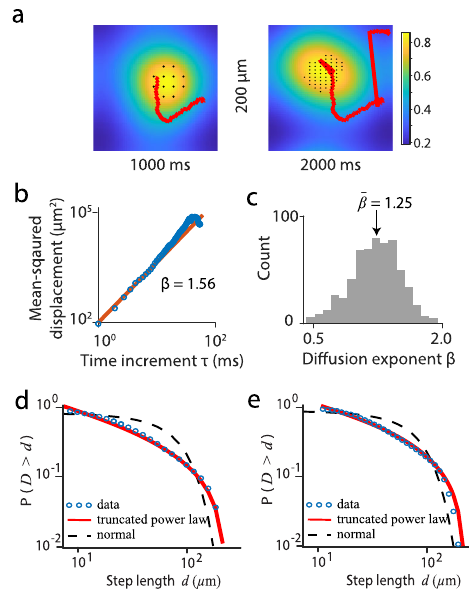
Fig. 6 Spatiotemporal dynamics of gamma patterns in the circuit model. a Snapshots of gamma-band LFP amplitudes at two timepoints. Black dots show the positions of gamma bursts in the model circuit. Amplitude patterns are overlaid with representative trajectories (red lines) of the center of mass of the burst patterns over the previous 30 ms (left) and 270 ms (right), respectively. b Mean square displacement (MSD) of a typical spiking pattern as a function of time increment. Red line shows a fi tted power function of MSD, MSD τ ð Þ / τ β , with the diffusion exponent β = 1.56. c Distribution of diffusion exponent β for spiking pattern in simulation data (1000s); mean value is 1.25. d CCPD of the step lengths (1D model) of the activity pattern in the transition state (State II) (blue circles). Red line indicates a fi tted truncated power distribution with λ = 1.32. For comparison, a normal distribution (black dashed line) with mean μ = 0 : 59 ´ 10 2 and standard deviation σ = 0 : 69 ´ 10 2 is shown. e as d for angle model: ( θ ¼ 40 (cid:3) ), λ = 1.13, μ = 0 : 10 ´ 10 3 , σ = 0 : 95 ´ 10 2